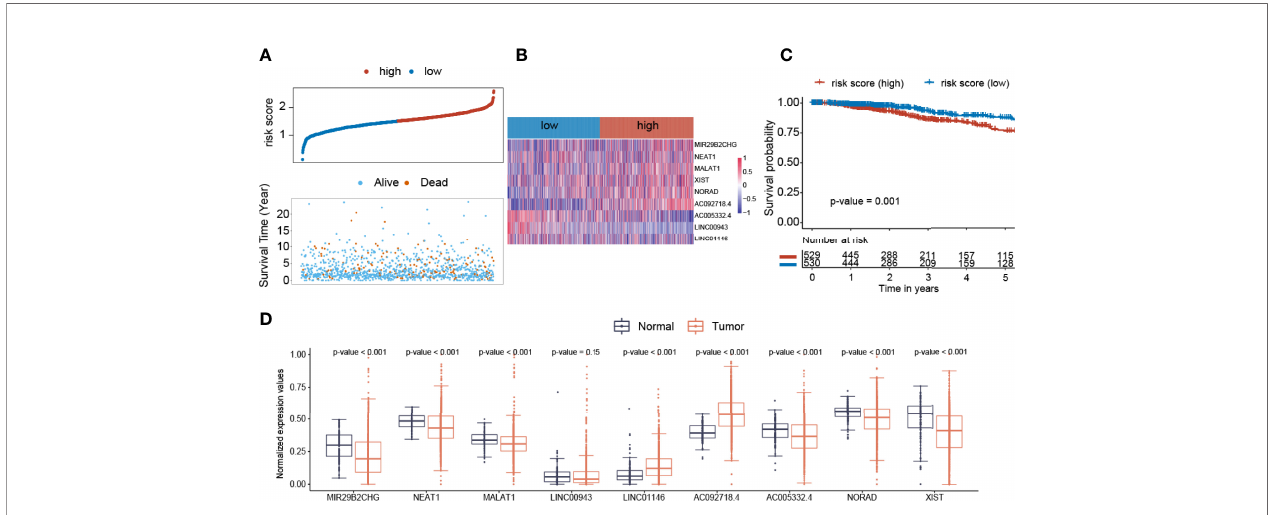
FIGURE 6 | Construction of the Cox regression model. (A) The distribution of prognosis including survival status and survival time between two risk score groups. (B) The heatmap of nine lncRNAs expression pro fi les. (C) The overall survival analysis of risk score groups. (D) The expression distribution values of nine lncRNAs between normal and breast cancer